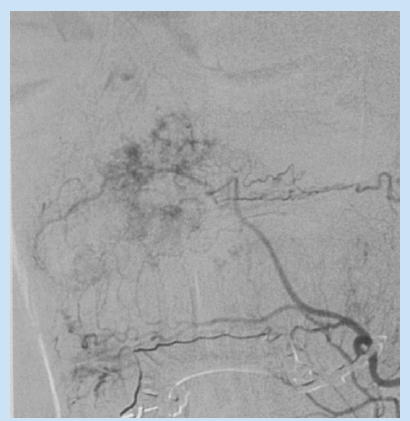
Fig 4a. Selective left facial arteriogram in our HHT patient showing multiple enhancing lesions repre- senting small nasal mucosal telangiectasias.